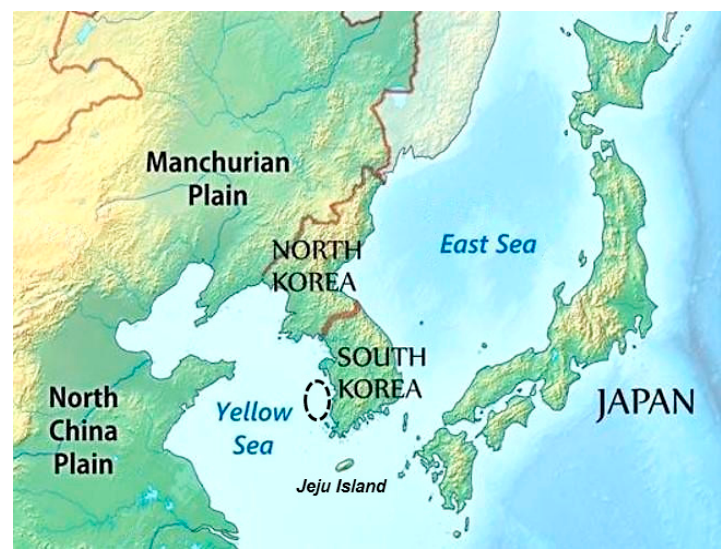
Figure 1. East Asia map around the Korean Peninsula (the dashed circle indicates the Southwest